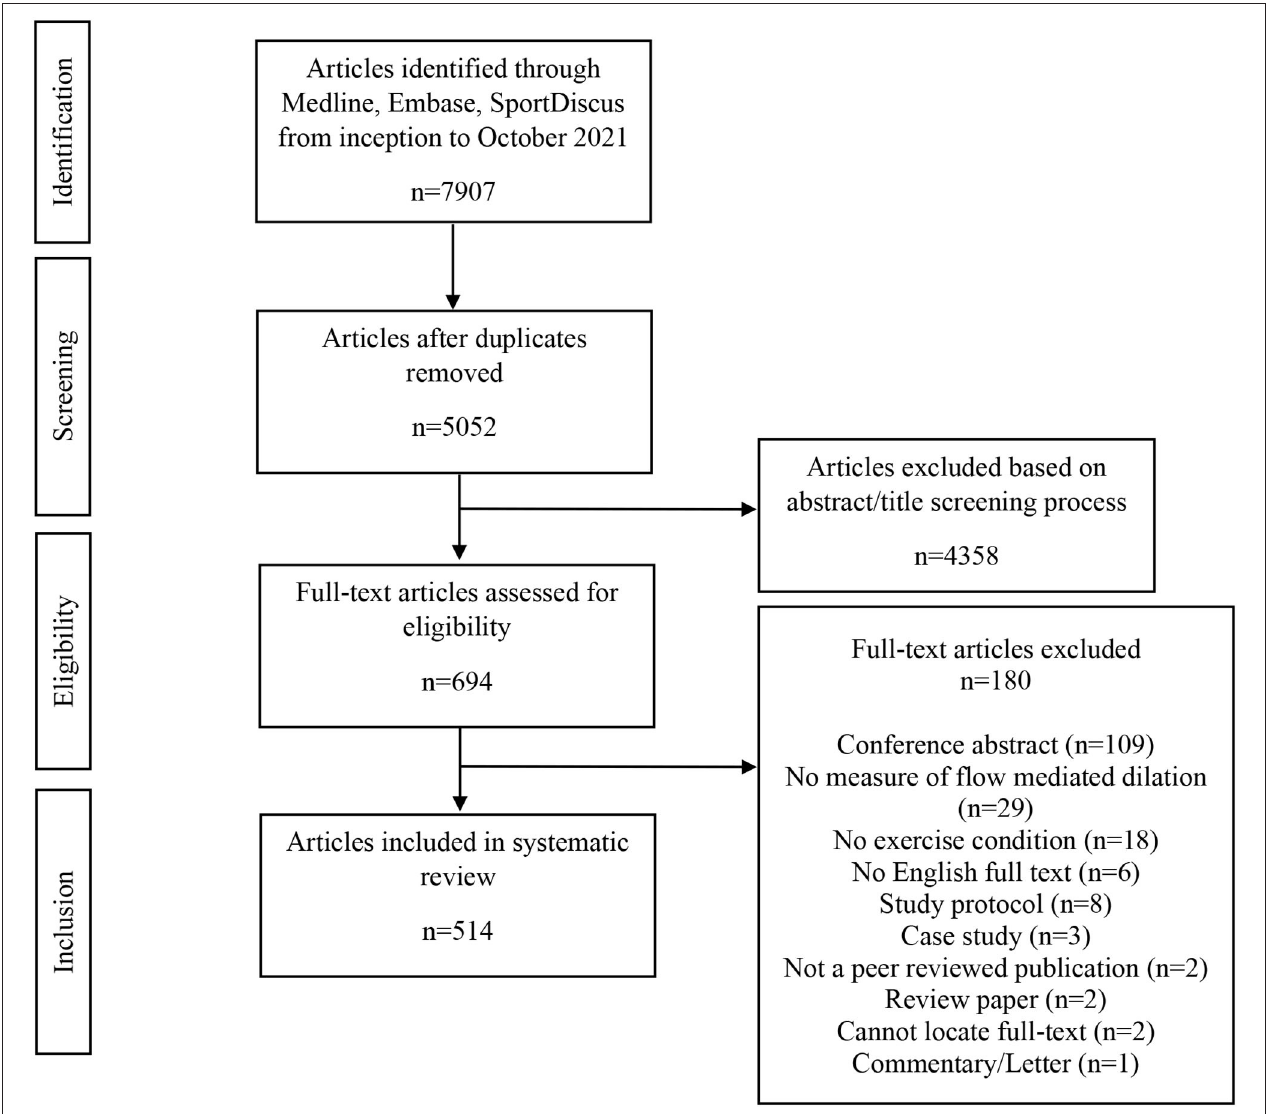
FIGURE 1 | Systematic review